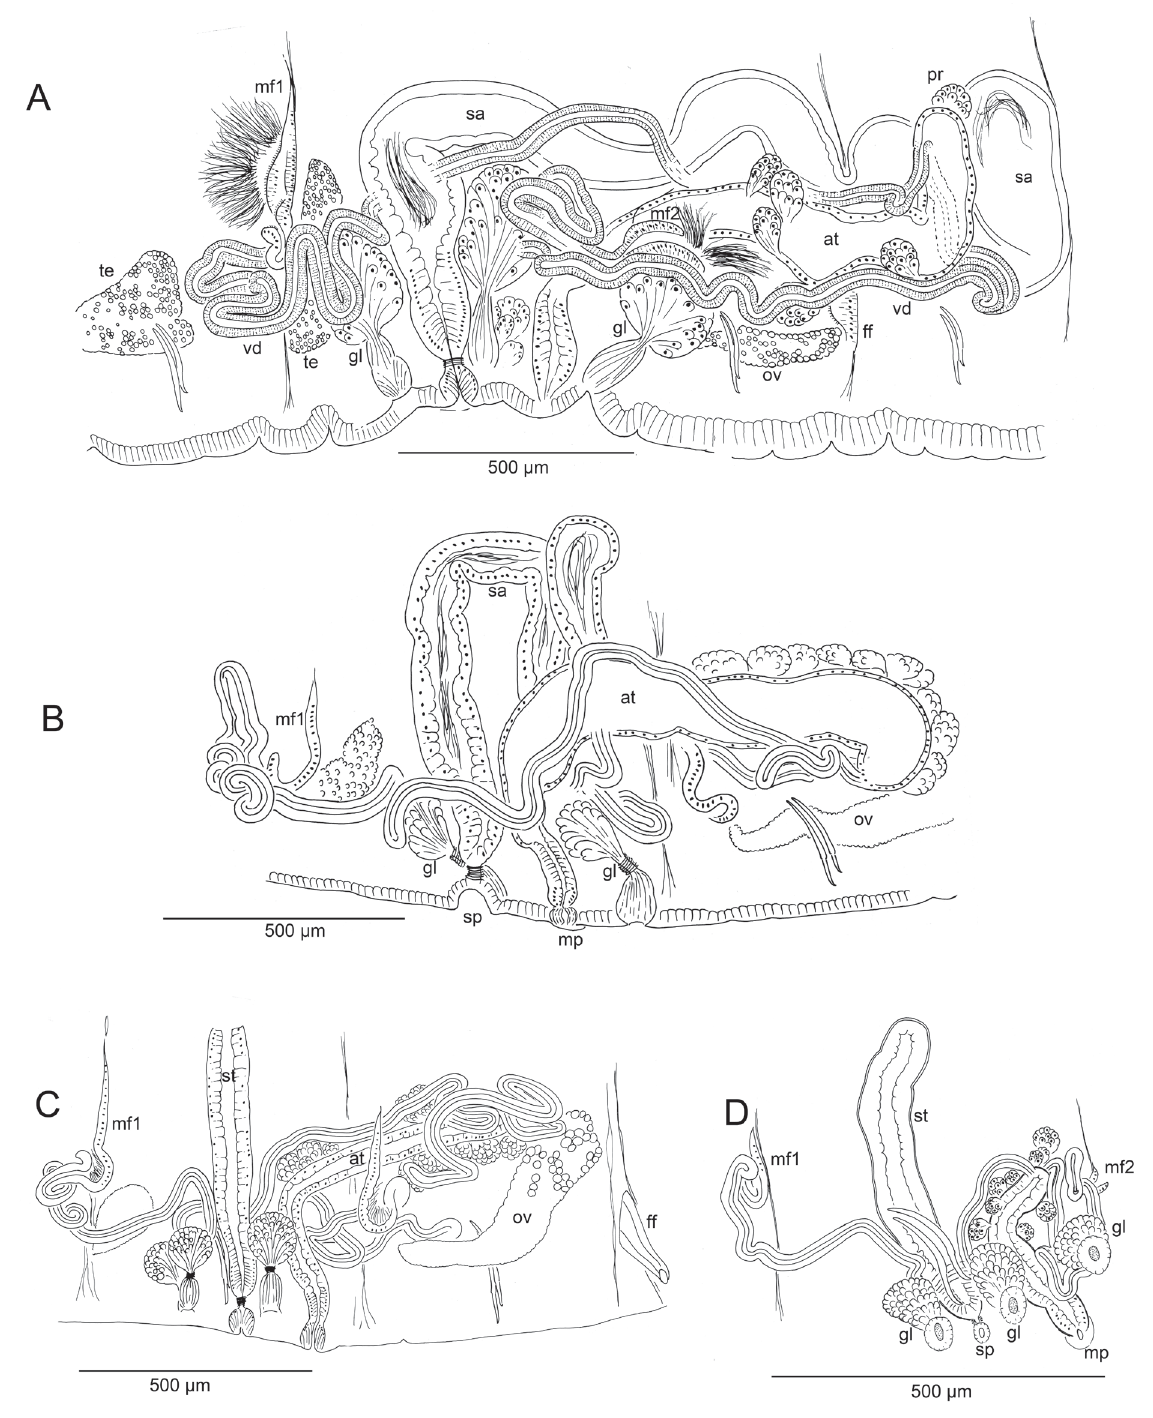
Fig. 8. Guestphalinus exilis Fend & Rodriguez sp. nov., reproductive structures, all oriented with anterior end to left. A–C from Squaw Creek (the type locality), D from the South Fork Eel River A . Segments VIII–XI of a mature worm, showing reproductive organs; anterior vas deferens broken at spermatheca. B . Segments IX–X of a recently-mated worm; spermathecal ampulla not yet developed; atrium expanded. C . Segments IX–X of a partially-mature worm; atrium and spermathecae tubular, but copulatory glands well-developed; ental end of spermatheca missing. D . Segment IX of a partially-mature worm; glands well developed; atrium and spermatheca small,